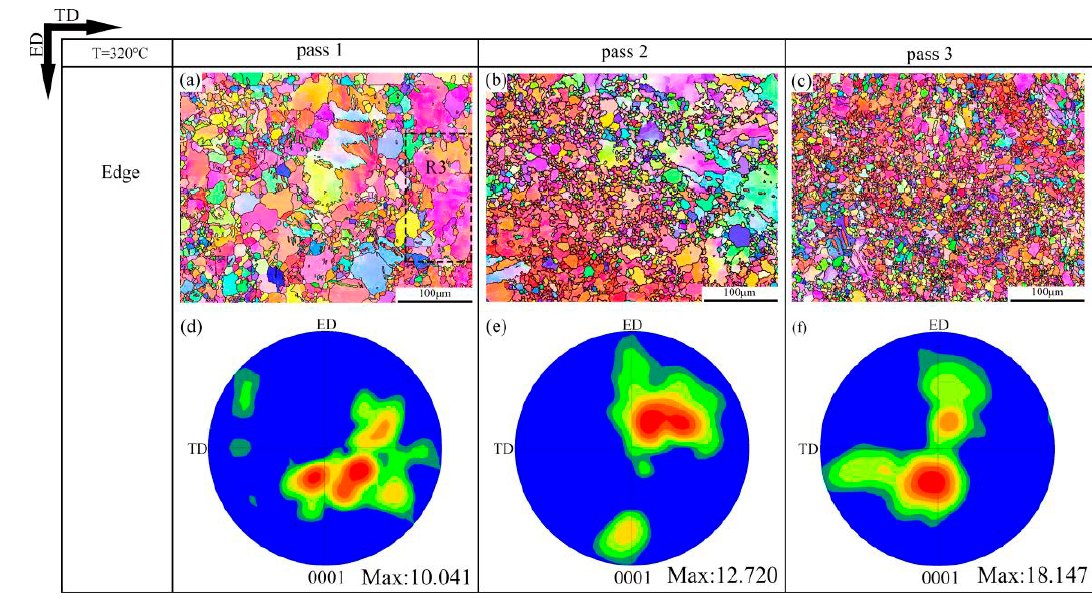
Figure 6. The EBSD inverse pole figure maps and (0001) pole figure maps of the CEE-AEC samples at 320 °C: ( a ) IPF map of Edge pass 1; ( b ) IPF map of Edge pass 2; ( c ) IPF map of Edge pass 3; ( d ) The corresponding (0001) pole figure in (a); ( e ) The corresponding (0001) pole figure in (b); ( f ) The corresponding (0001) pole figure in (c).